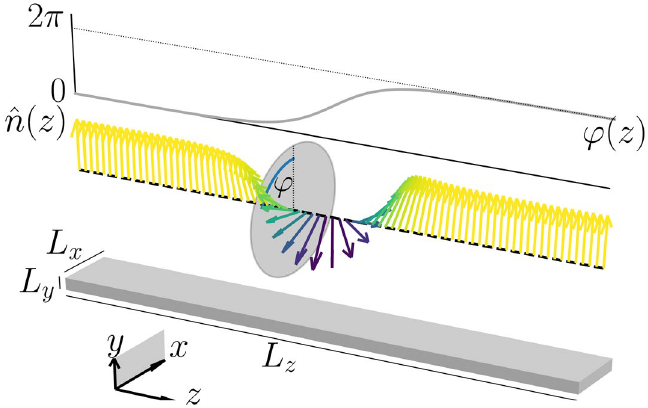
Figure 1. Structure of the quiral soliton and geometry of the system. The χ = + 1 chiral soliton is described by ˆ n ( z ) with ϕ( z ) given by ϕ 0 in Eq. (5) (top). The polar angle is θ = π/ 2 and thus the normalized magnetization ˆ